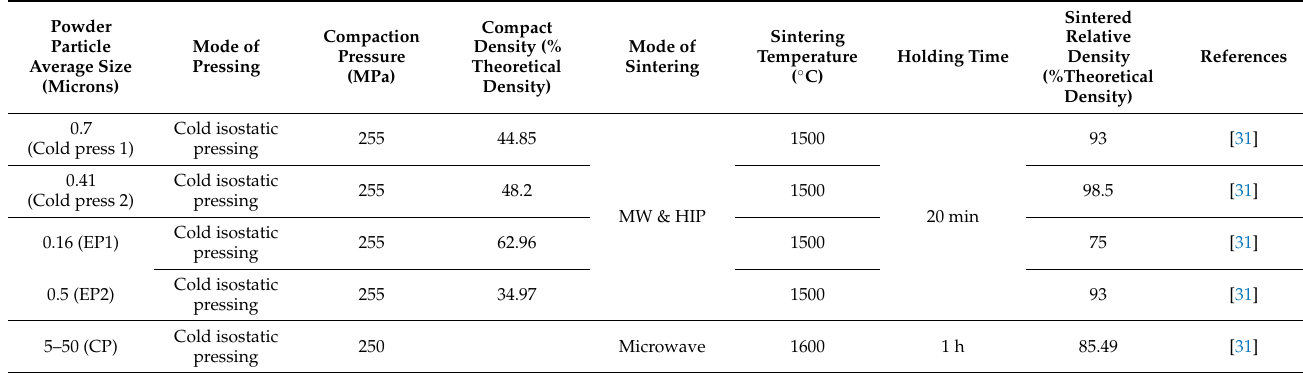
Table 2. Effect of powder size on relative density of W.